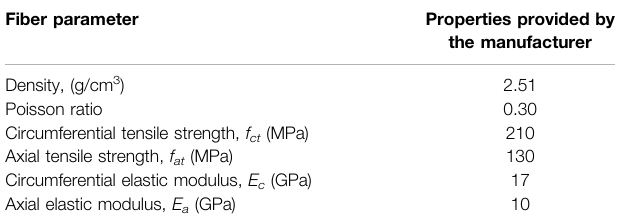
TABLE 3 | Material properties of FRP tubes.